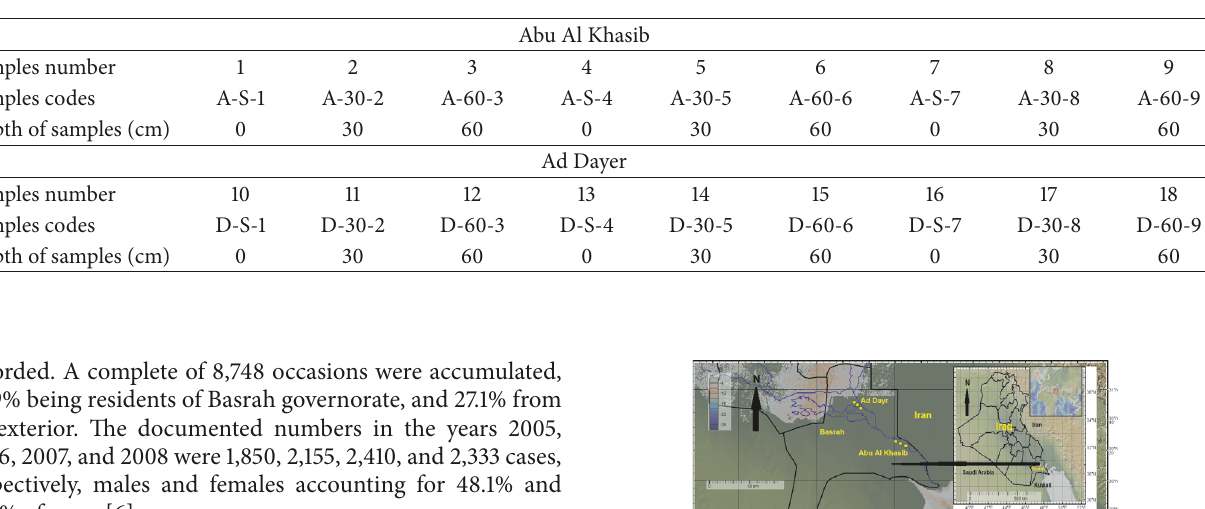
Table 1: Samples regions, depths, and codes indices [7].